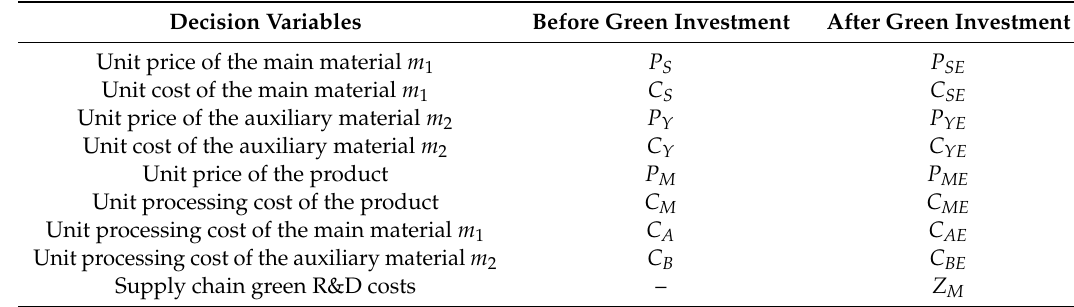
Table 1. Decision variables before and after green